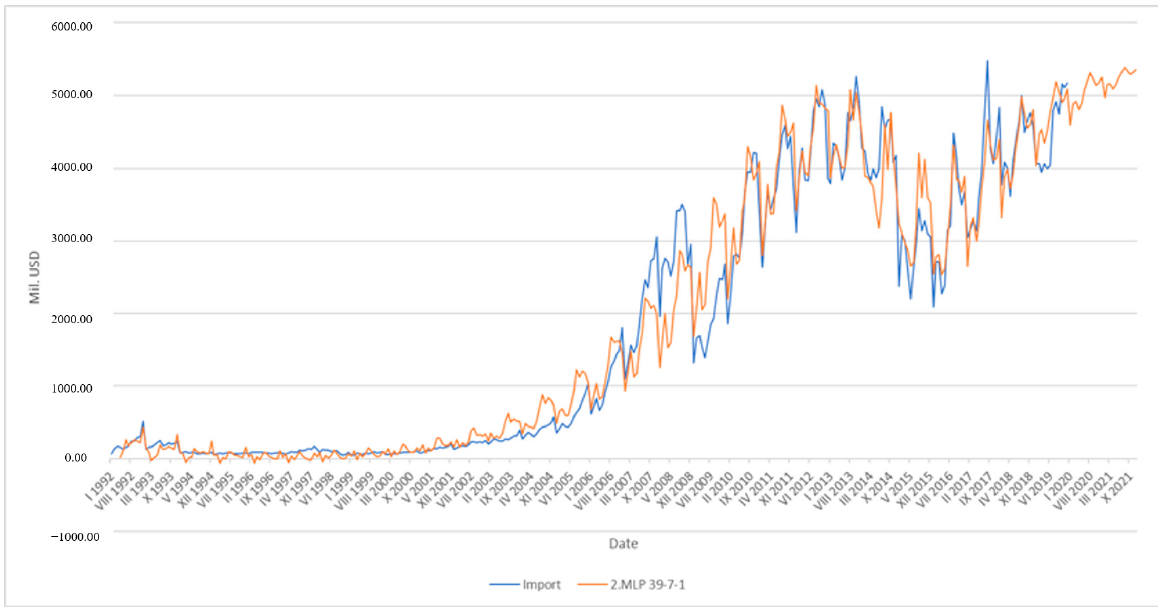
Figure 5. Comparison of export and equalized time series of RF import from PRC with prediction until December 2021 (Source: